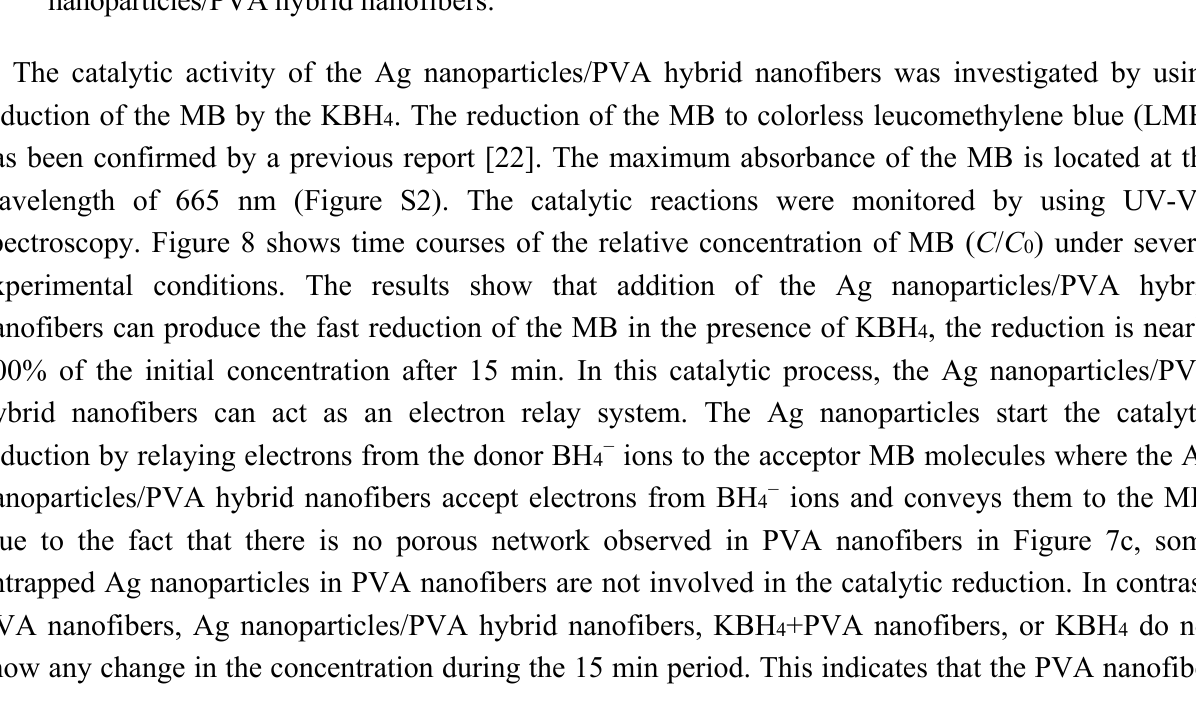
Figure 7. Scanning electron microscopy (SEM) image ( a ); energy dispersive spectrum (EDS) ( b ); transmission electron microscopy (TEM) image ( c ) of prepared